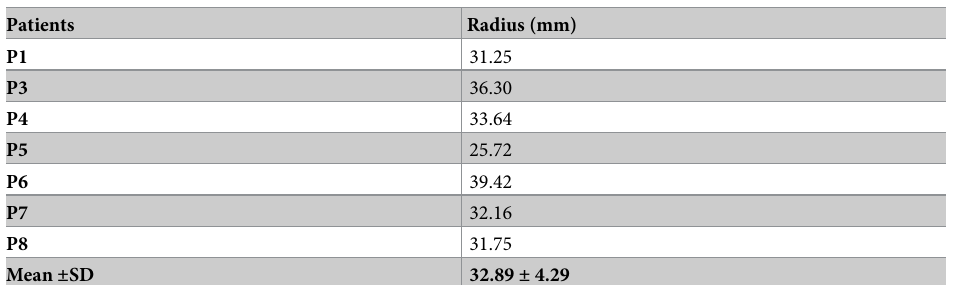
Table 3. Radius of the